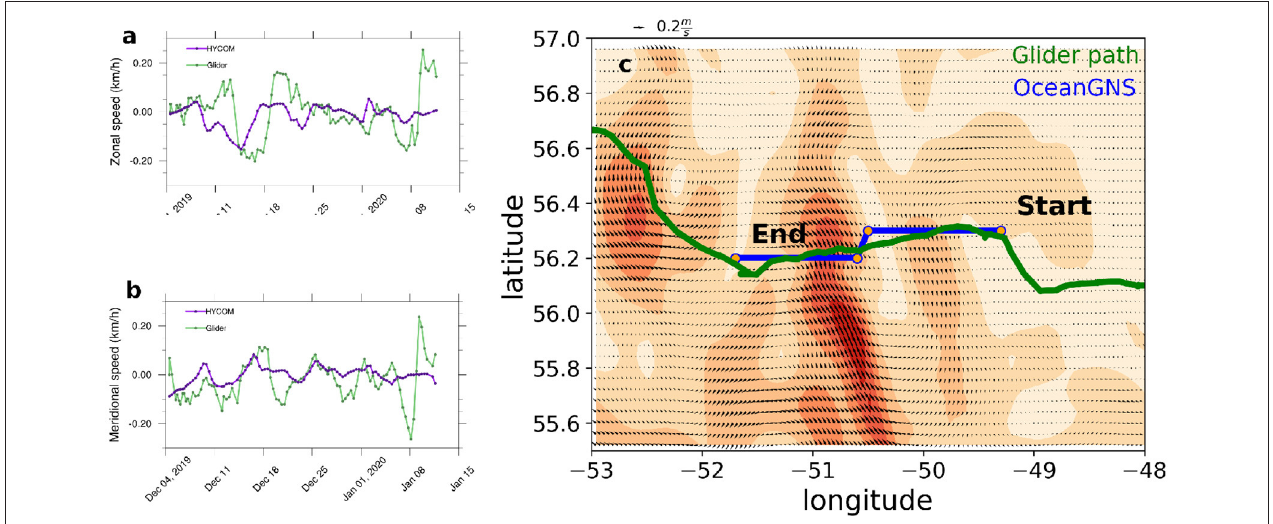
FIGURE 9 | Results of OceanGNS tests for the Labrador Sea. (a,b) Shows the close agreement between glider dead-reckoned currents (u,v component) and the HYCOM model used in these navigation tests. (c) Shows an example from the route–planning done for the mission with the glider track (red) and the planned track (blue) transmitted to the glider from